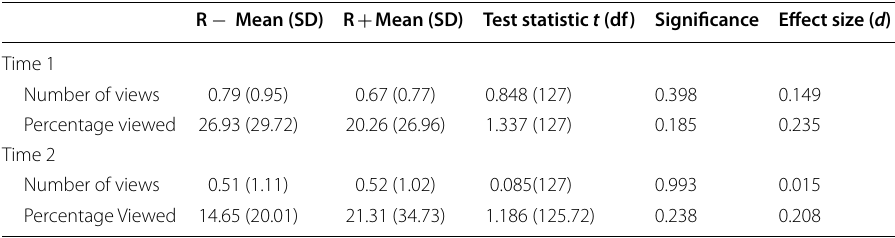
Note that this pattern of significance is maintained when only the subset of participants who completed the survey are analysed (N =